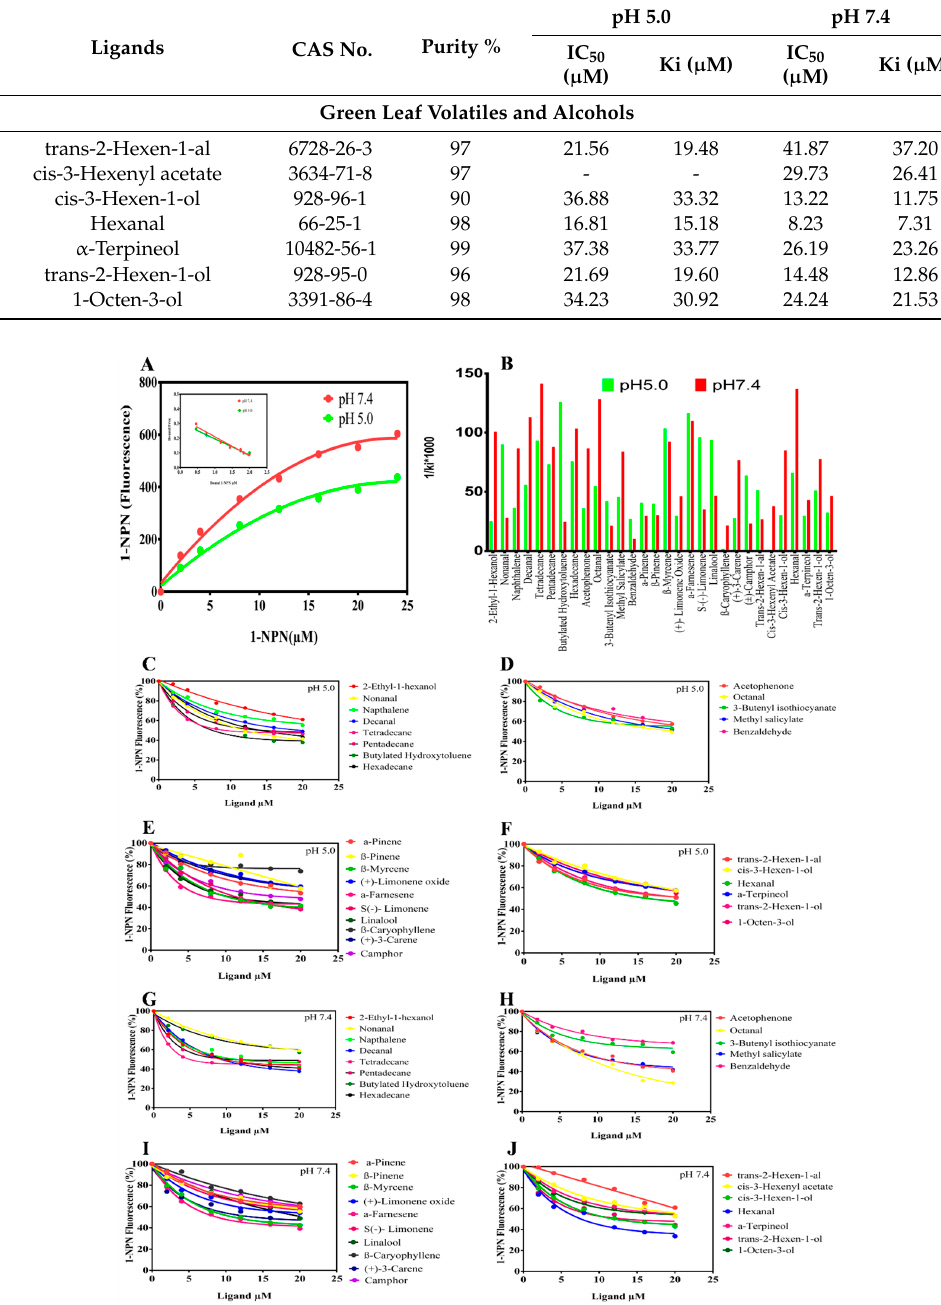
Figure 3. Fluorescence competitive ligand-binding assays of SaveOBP9. ( A ) The binding curves for 1-NPN SaveOBP9 at two different pH, i.e., pH 5.0 and 7.4. A 2 μ M solution of SaveOBP9 in 30 mM Tris-HCL buffer (for pH 5.0 and 7.4, used separately) was titrated through a 1 mM 1-NPN solution in spectrophotometric-grade methanol to an ultimate concentration of 0–20 μ M, and the emission spectrum was recorded between 350 and 600 nm. ( B ) Comparison of ligand binding affinity (indicated by 1/Ki × 1000) of SaveOBP9 with 30 compounds at pH 5.0 and 7.4. ( C , G ) Competitive binding curves of compounds identified in GC-MS, ( D , H ) general odorants and phenylpropanoids, ( E , I ) terpenoids, ( F , J ) green leaf volatiles and alcohols to SaveOBP9 at pH 5.0 and 7.4, respectively. A mixture of the recombinant SaveOBP9 and 1-NPN in 30 mM Tris-HCL (pH 5.0 and pH 7.4) was titrated with 1 mM solution of each competing ligand to an ultimate concentration of 0–20 µ